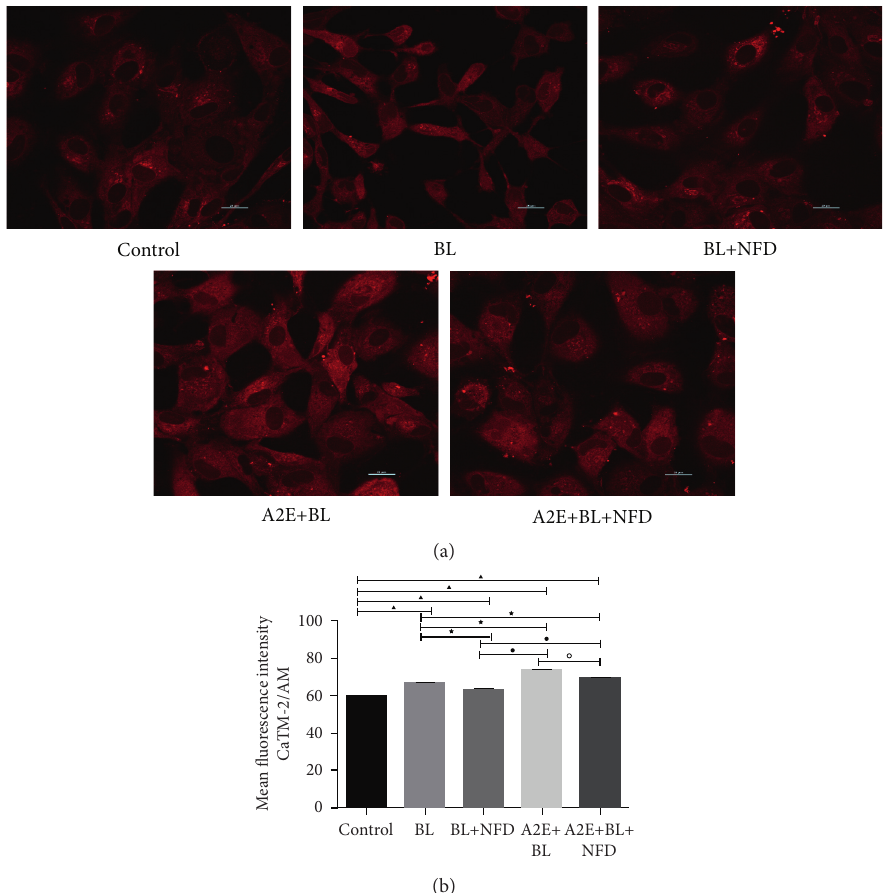
Figure 2: The level of calcium in the cytoplasm. (a) To investigate the Ca 2+ level in the cytoplasm, we performed CaTM-2/AM staining. Our data showed that blue light and A2E significantly elevated the cytoplasmic Ca 2+ levels compared with those in the nontreated cells. Scale bar � 20 μ M. (b) Data are presented as the mean ± SD ( n � 3). An LSD test following one-way ANOVA was performed for the statistical analysis. ▲ P < 0 . 05, compared with the controls; ★ P < 0 . 05, compared with the BL group; ● P < 0 . 05, compared with the BL+NFD group; and ◇ P < 0 . 05, compared with the A2E